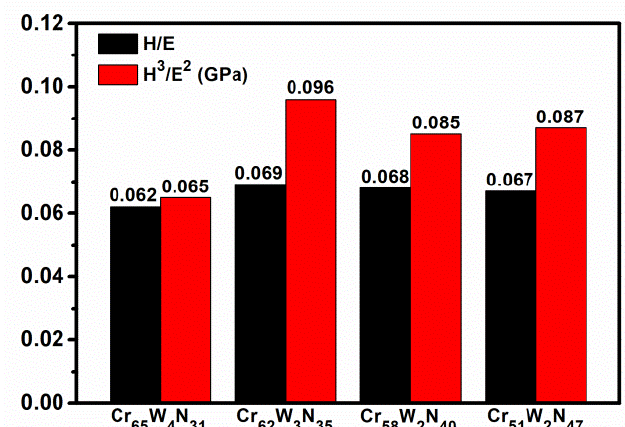
Figure 8. H/E and H 3 /E 2 ratios of CrWN coatings.